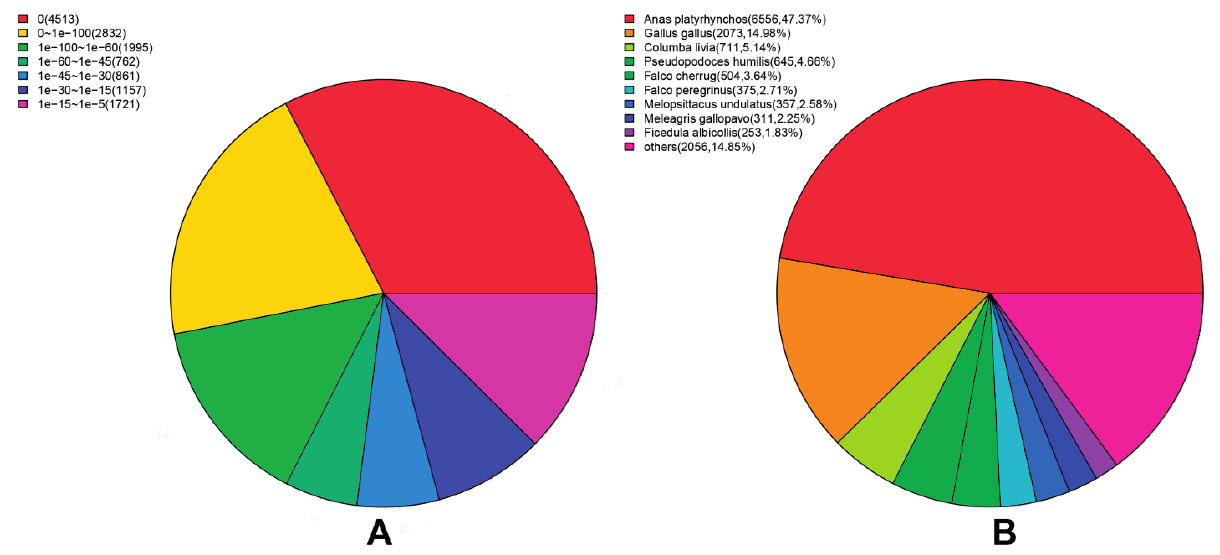
Figure 4. Statistical analysis of the assembled unigenes against Nr database. ( A ) E -value distribution; ( B ) Species